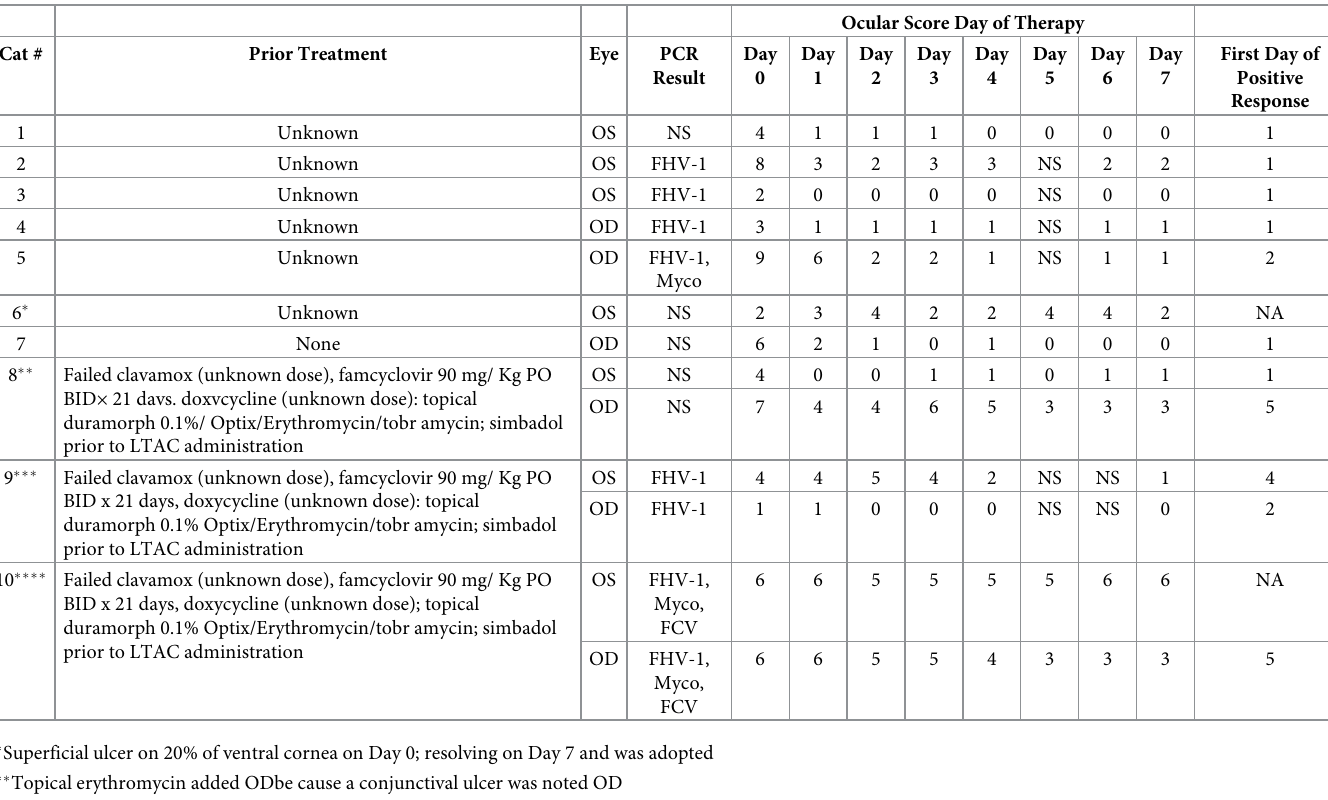
Table 2. Clinical responses of cats with naturally occurring conjunctivitis/keratitis when administered the LTC nanoparticle